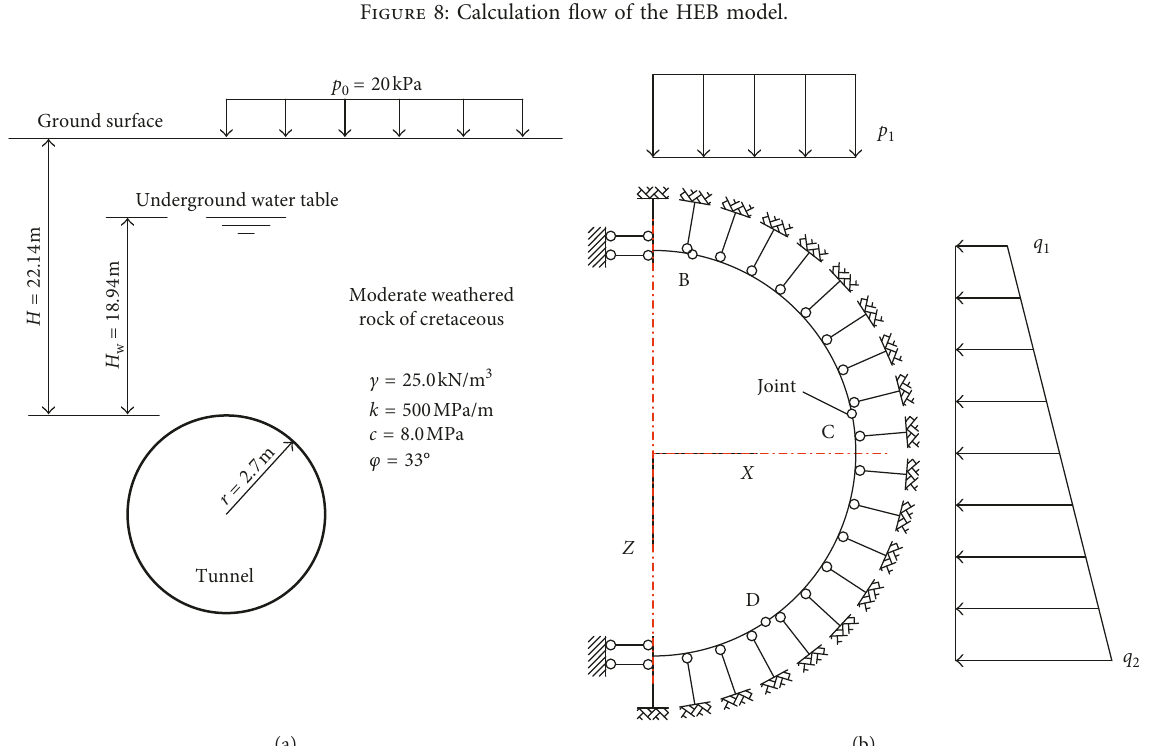
Figure 9: Calculation model. (a) Geological condition. (b) Structural calculation